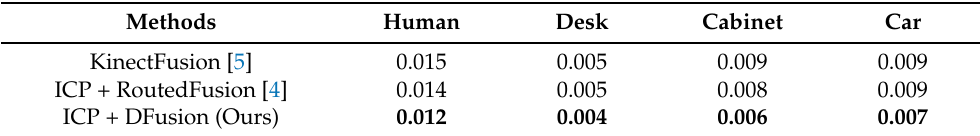
Figure 7. Fusion results on the CoRBS dataset. ICP algorithm [36] is used to obtain the sensor trajectory for RoutedFusion and DFusion. Table 3. Quantitative results (MAD) on the CoRBS dataset.